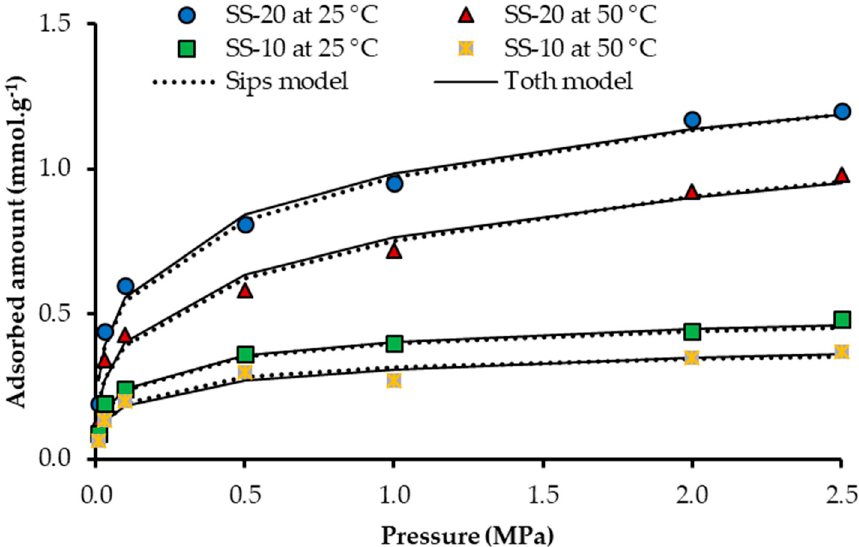
Figure 7. Adsorption isotherms of CO 2 at high pressure (up to 2.5 MPa) of SS-10 (sandstone impregnated with a mass fraction of 10% CN.RON2) at 25 and 50 ◦ C, and SS-20 (sandstone impregnated with a mass fraction of 20% CN.RON2) at 25 and 50 ◦ C.